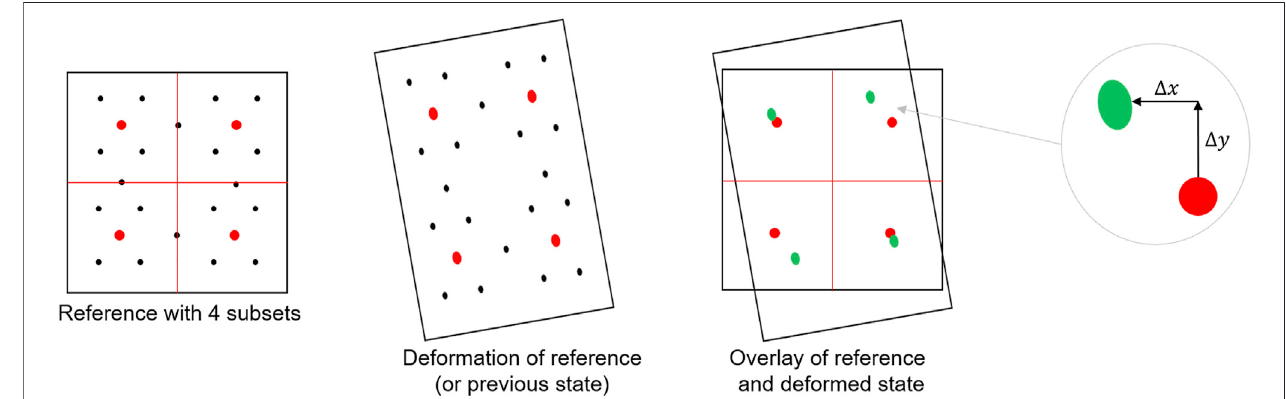
FIGURE4 | Schematic illustration ofthe principles ofDigitalImageCorrelation.A reference pattern (microstructure) isdivided intosubsets (herefour for the sakeof clarity) and de fi ned as the undeformed state. Then, the reference deforms and becomes the deformed state. The subsets also exist in the deformed state (not shown). Each pattern (any feature) has x and y coordinates and an intensity. The two states are correlated, and the difference of all patterns is calculated.